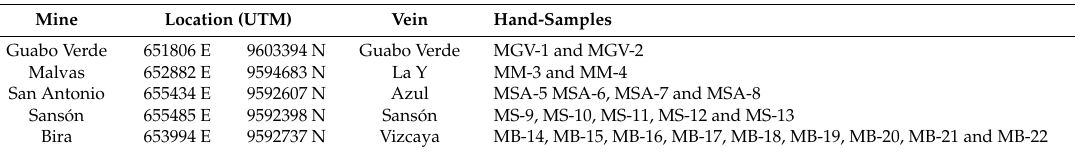
Table 1. General information about the collected and selected ore samples (22 hand-specimens) and corresponding mines and